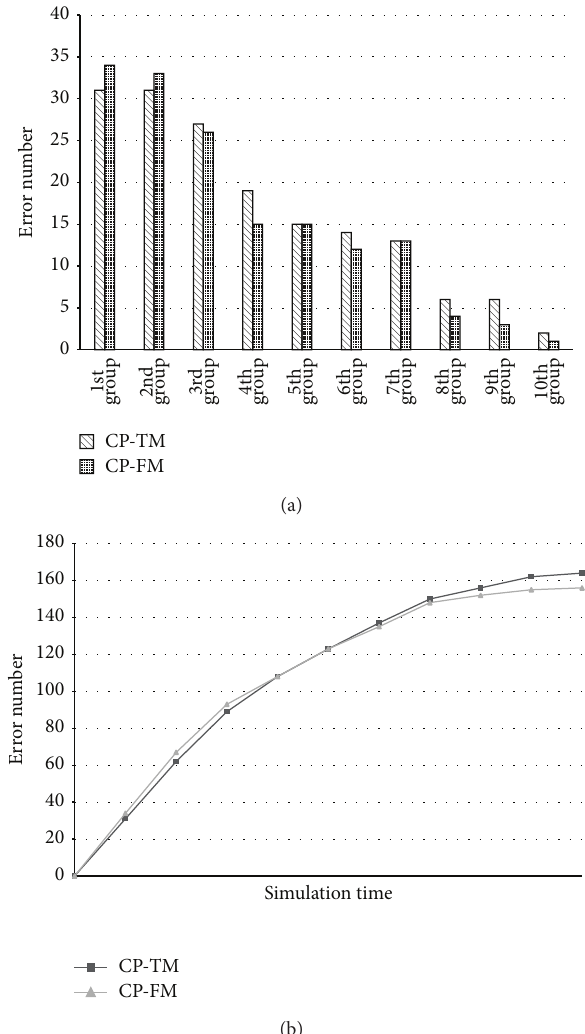
Figure 14: (a) Error number found by test groups; (b) accumulated errors found by the function-accurate model and timing-accurate model of CPU